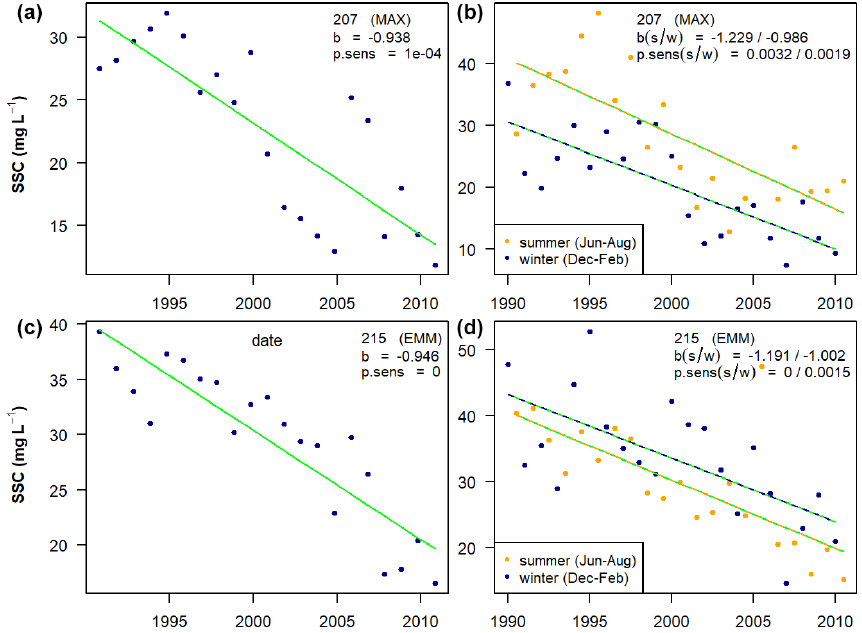
Figure 4. Examples of SSC trends between 1990 and 2010 for monitoring station Maxau (a, b) and Emmerich (c, d) . Panels (a, c) show annual average SSC, and panels (b, d) show trends during summer and winter months.